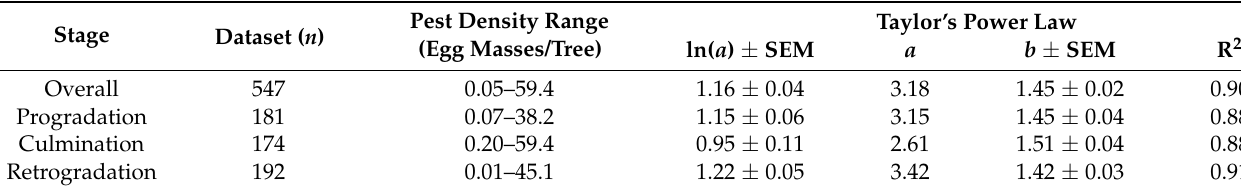
(Figure 1B). At the same egg mass density, stop lines calculated at P = 0.25 and 0.10 indi- cated that sampling should be stopped at 76 (Figure 1C) and 479 cumulative egg masses (Figure 1D), respectively. Table 1. Dispersion indices for Lymantria dispar egg masses on cork oak trees in Sardinia (Italy) in 1999–2010.